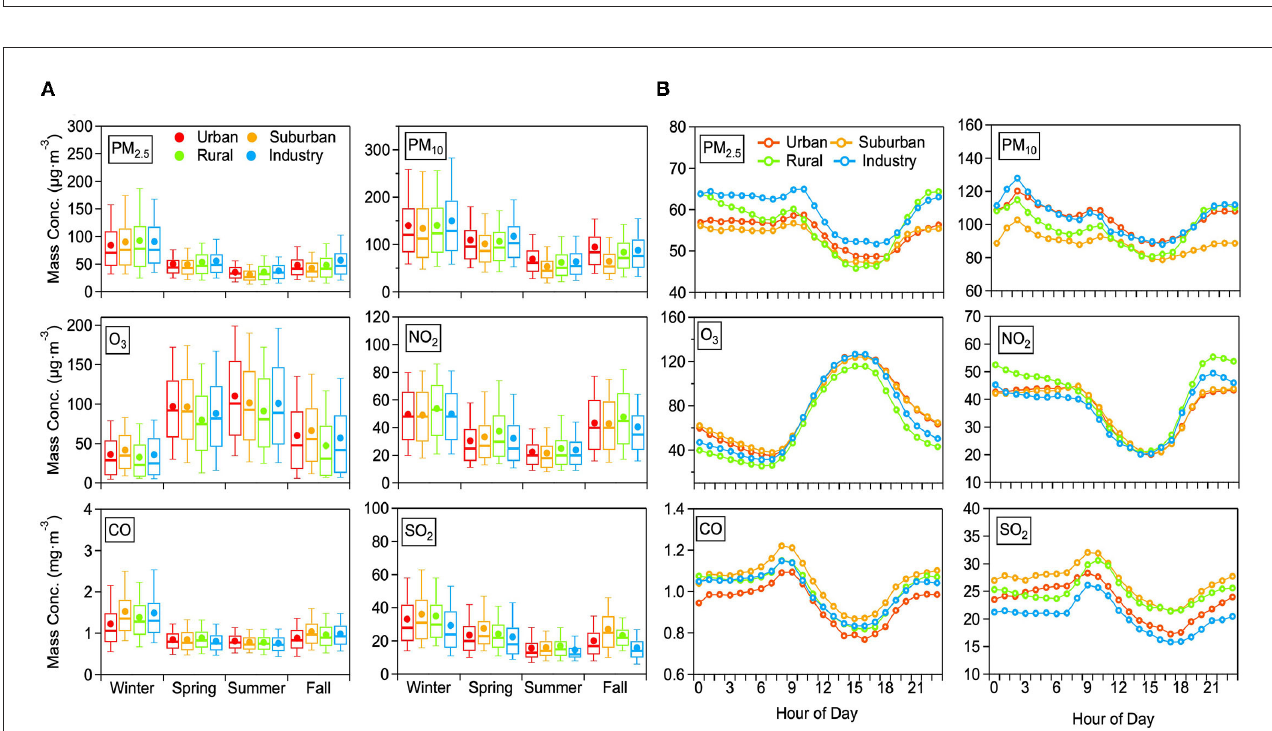
FIGURE3 The seasonal (A) and diurnal (B) distributions of the six pollutants averaged over 2017 and 2018 for each of the functional areas (color-coded).